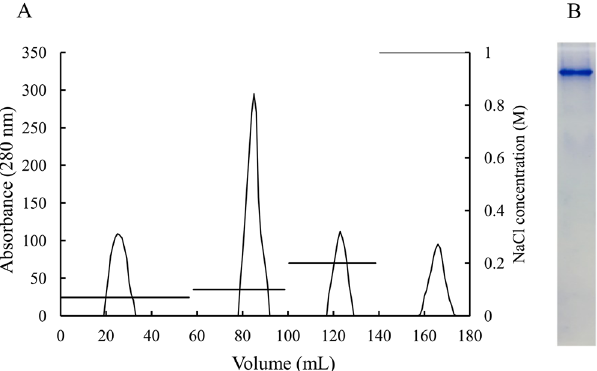
Figure 3. DEAE anion exchange column of guppy Lv ( A ) and Native-PAGE (4–7.5%) of the peak eluted with buffer containing 0.1 M NaCl ( B ).